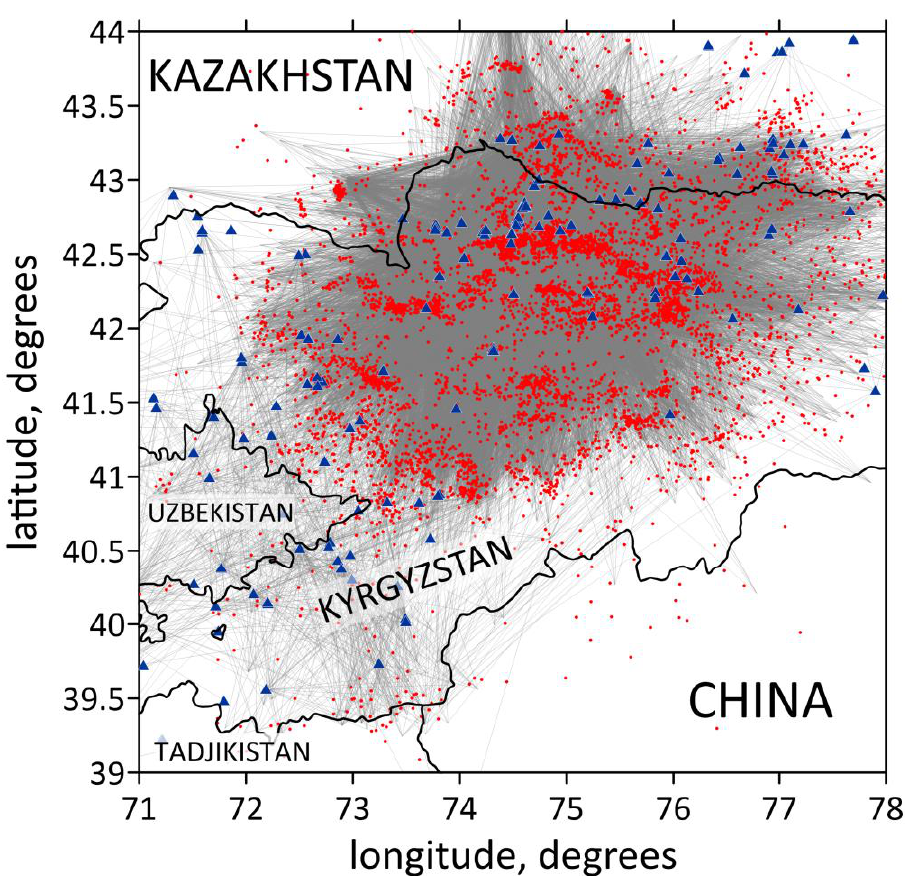
Figure 3. Observation network: earthquakes (red dots), stations (blue triangles) and rays (gray lines). Table 1. One-dimensional reference model.